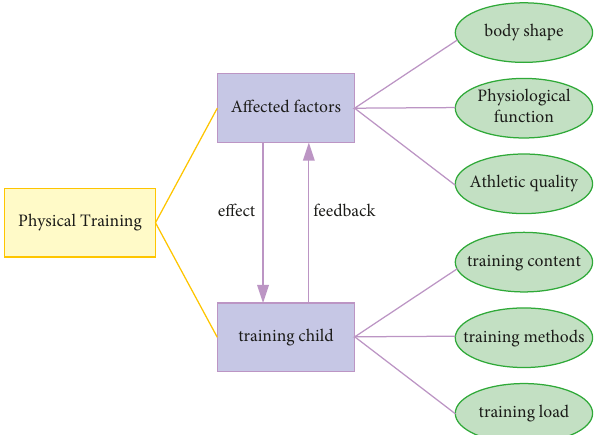
Figure 7: Display of physical fitness training content and affected